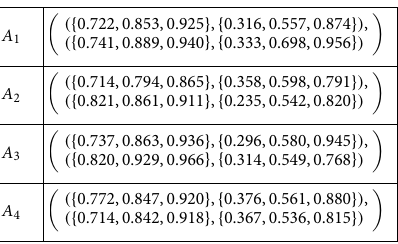
Table 8. Information aggregated employing FHFRHWA.